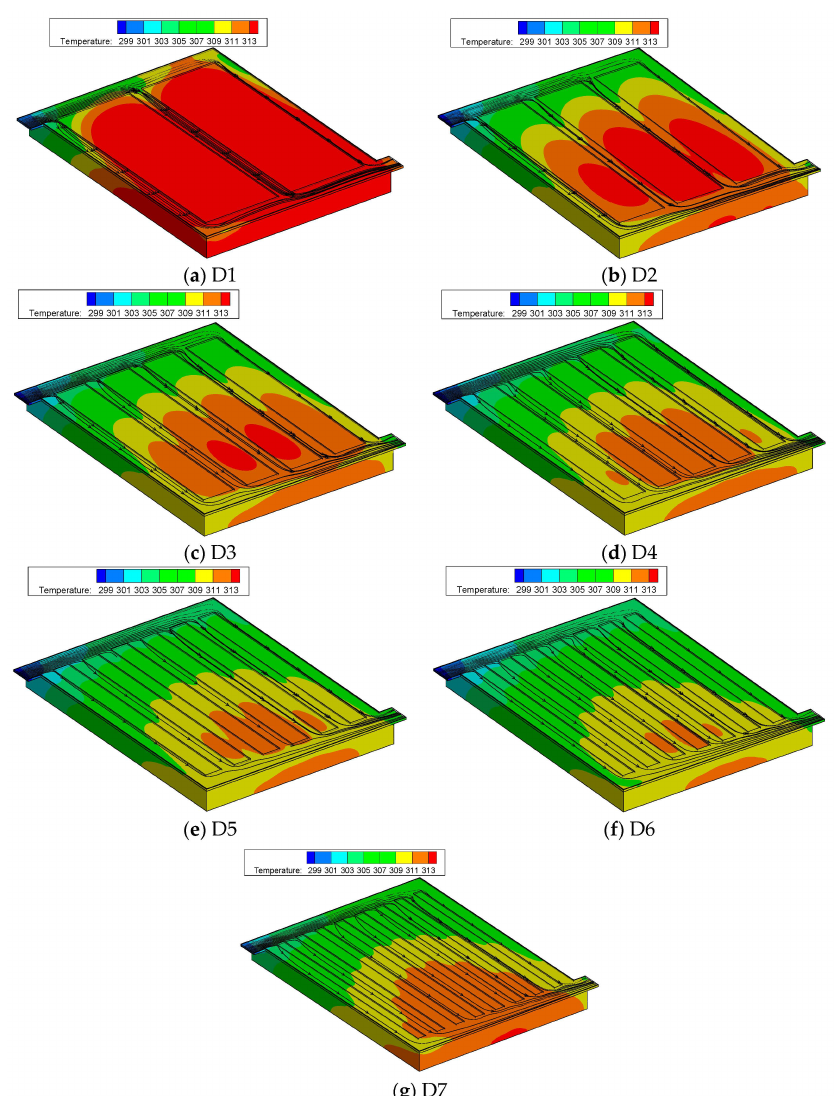
Figure 7. Temperature contours with superimposed streamline at t = 1080 s for Z-type parallel channel cold